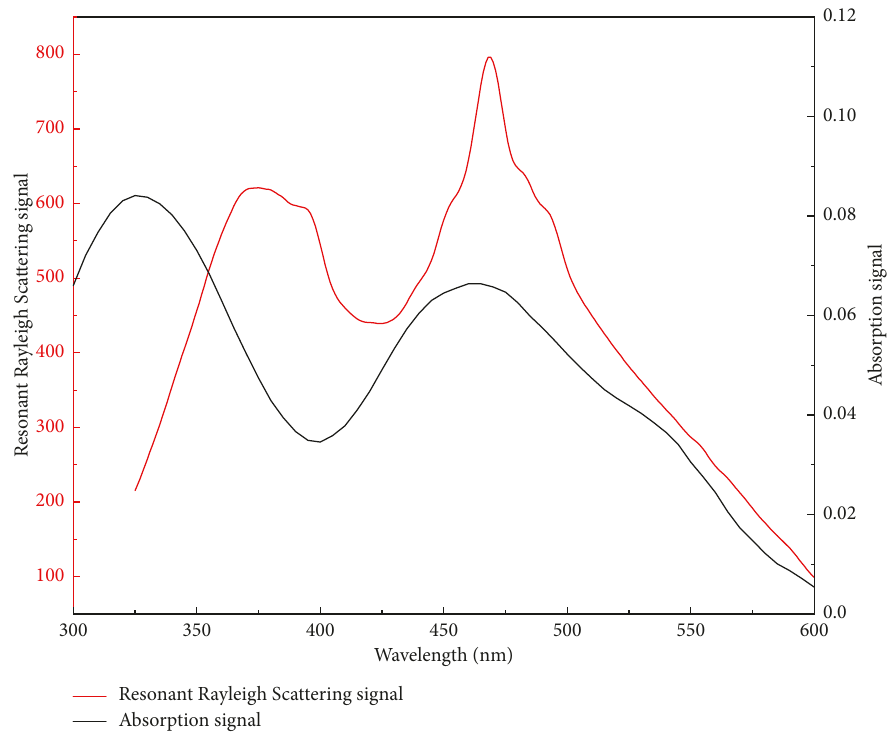
Figure 8: Resonant Rayleigh scattering spectrum and absorption spectrum of congo red-neomycin-DTAB. 1 mL pH 6.0 Britton–Robinson buffer solution, congo red: 1.5